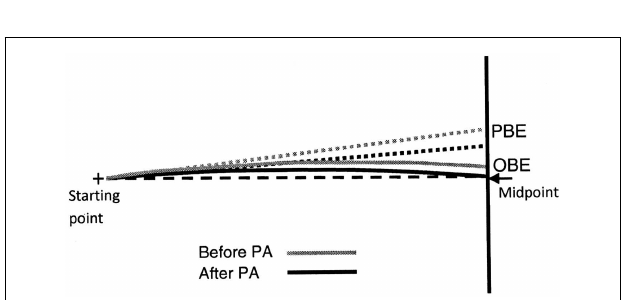
FIGURE 11 | Graphic representation of the shape of MR’s predicted (dotted lines) and observed (continuous lines) walking trajectories prior (black lines) and after (gray lines) prismatic adaptation (PA) . Note that PA reduces both the predicted (PBE) and the observed (OBE) bisection error but does not modify the shape of the trajectories (continuous lines), showing that spatial remapping in patient MR is independent of